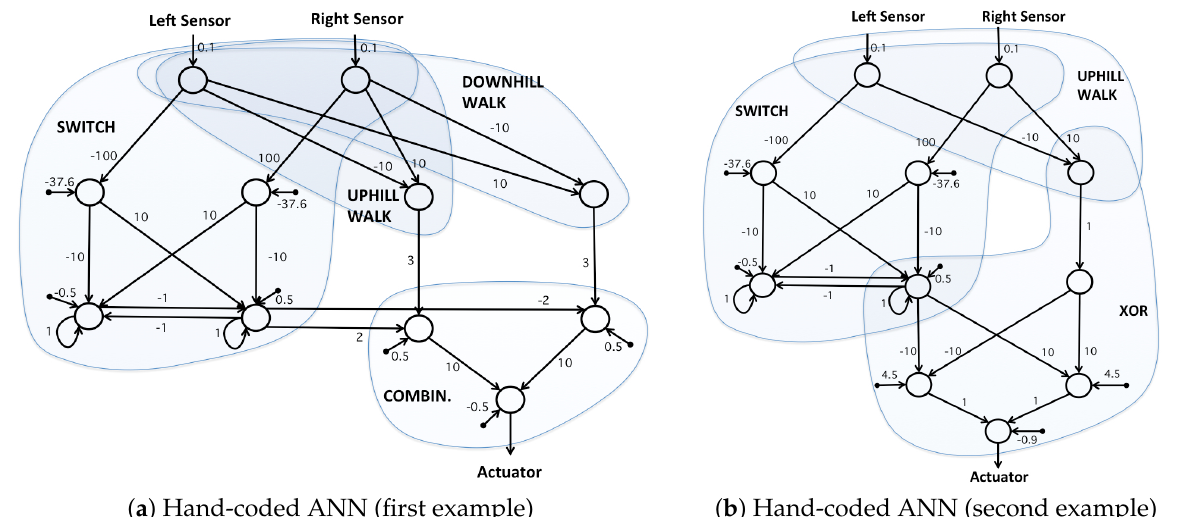
Figure 4. Schematic drawing of two example hand-coded ANN